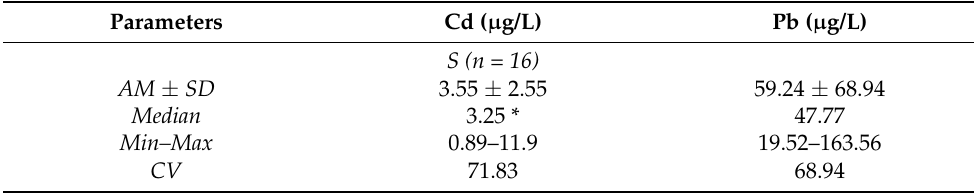
Table 4. Cadmium, mercury, and lead concentrations in blood erythrocytes of renal transplant recipients in aspect of smoking (S: smokers; EXS: ex-smokers; NS: never-smoking patients; AM: arithmetic mean, SD: standard deviation; Min-Max: minimum and maximum values; CV: coefficient of variation in %; * p < 0.05, statistically significant difference vs EXS, ** vs. NS). Parameters Cd ( µ